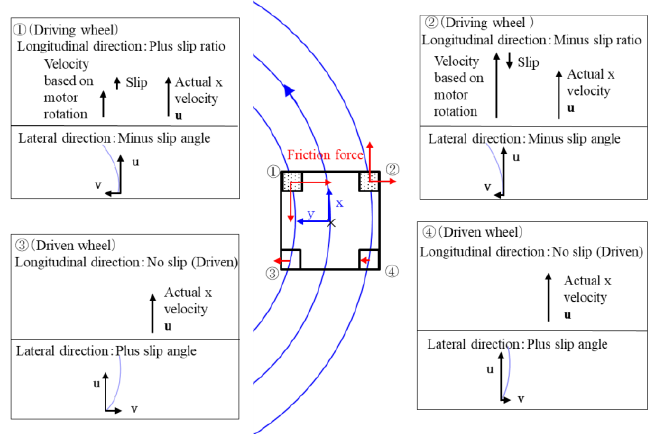
Figure 20. State of each wheel and friction force in forward movement. The red lines show the frictional